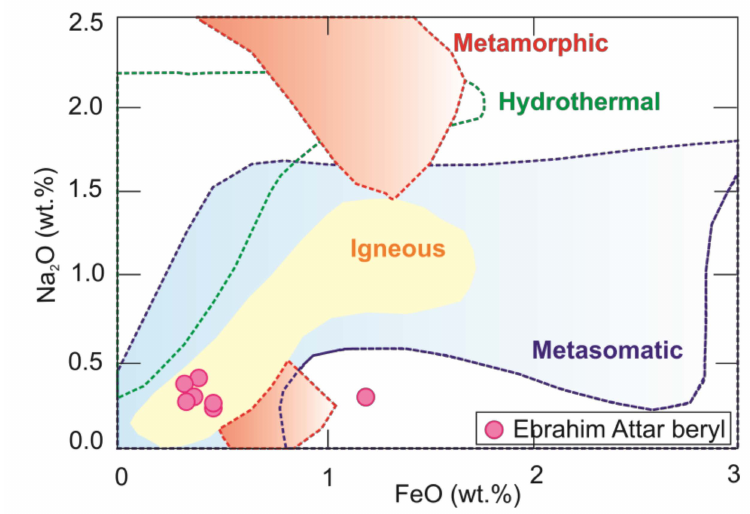
Figure 11. Na 2 O vs. FeO (wt.%) diagram. The Ebrahim-Attar beryl samples plot in the magmatic source field. Data for magmatic, hydrothermal, metasomatic, metamorphic, and hydrothermal beryl fields are from Merino et al.